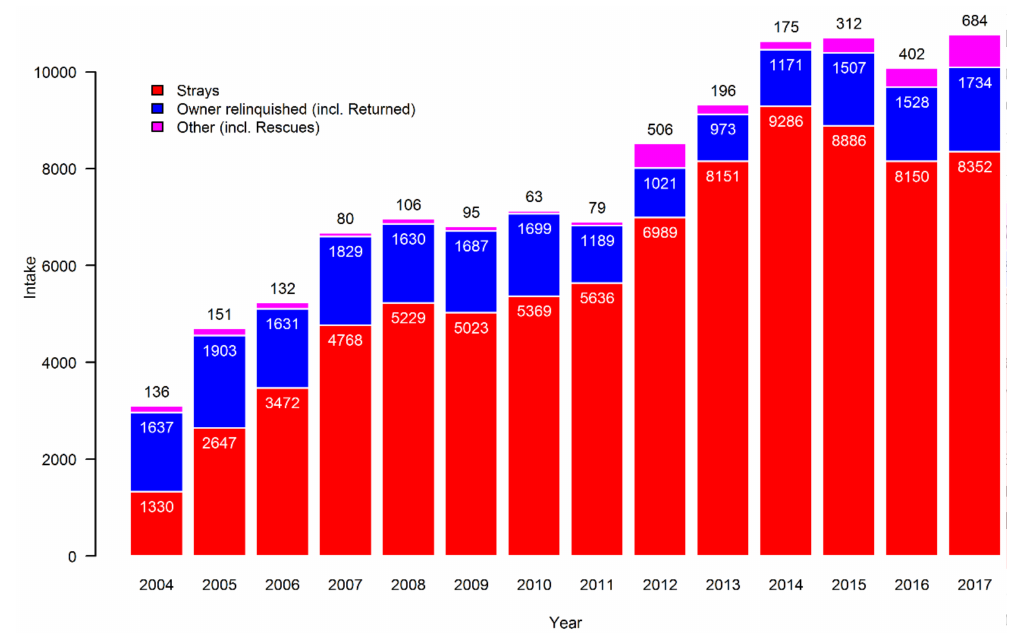
Figure 2. Sources of cats in the Danish shelters over the study period from 2004 to